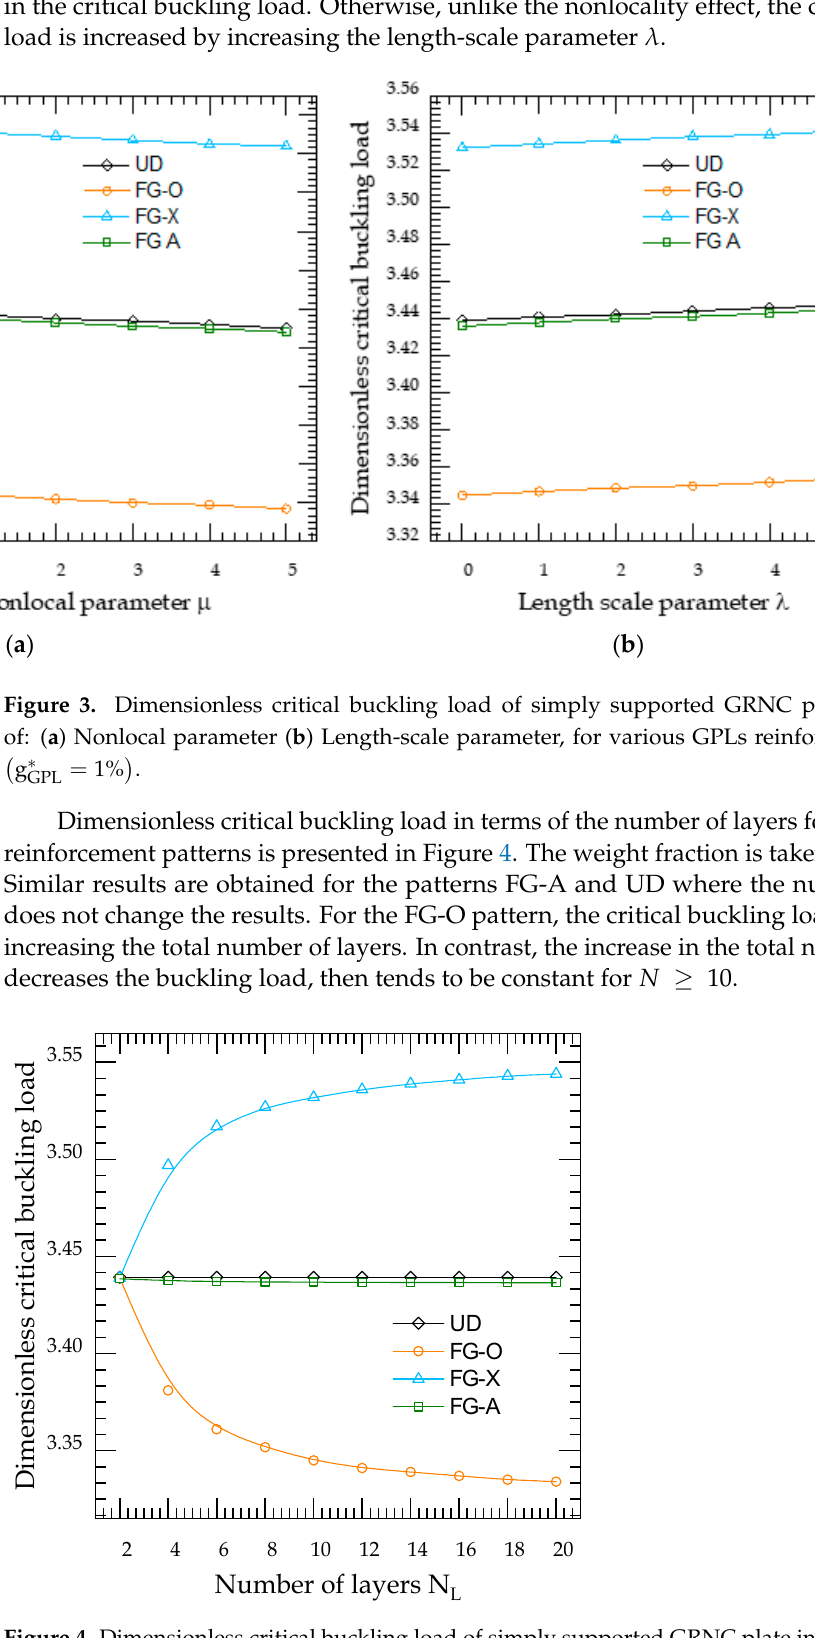
(cid:0) = 1% (cid:1) g ∗ GPL